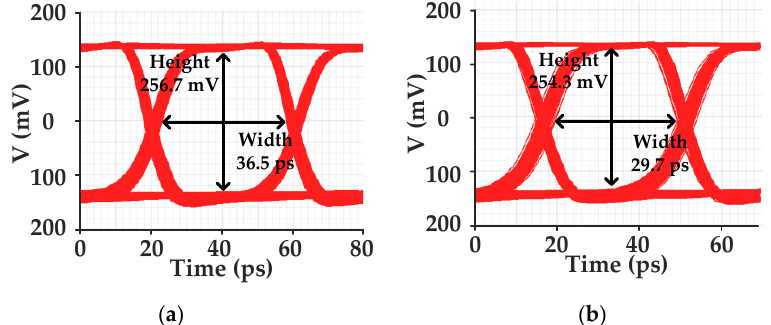
Figure 12. Simulated eye diagrams of the receiver in high-power mode. ( a ) 25 Gb/s; ( b ) 28.9 Gb/s.